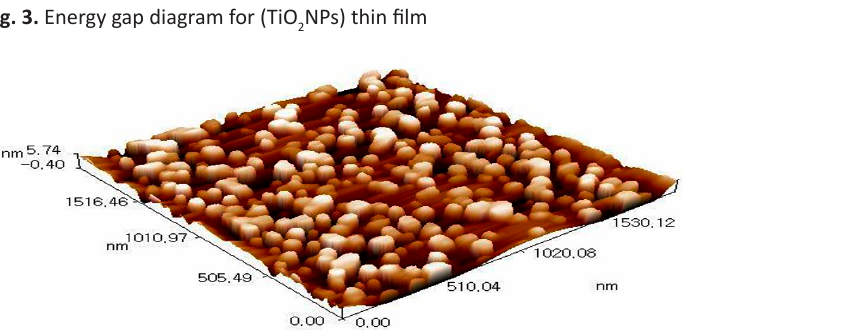
Fig. 3. Energy gap diagram for (TiO